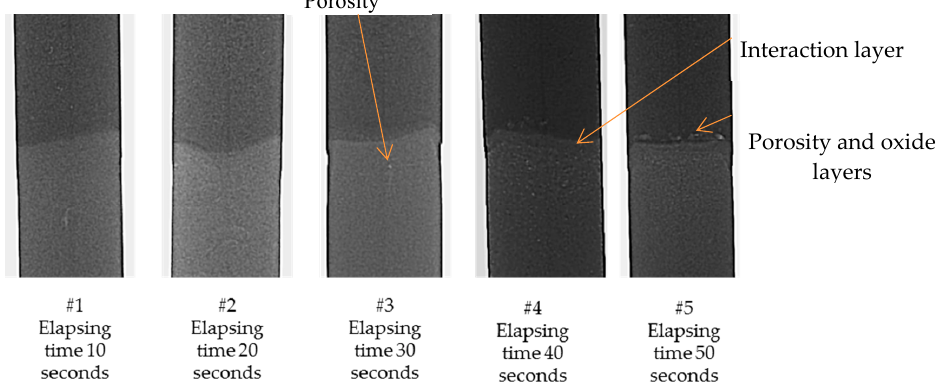
Figure 2. Sample interfaces EN AC 48000/EN AC 42100 obtained with RX analysis after sequential gravity casting at different conditions of waiting time. AlSi12CuNiMg is the dark grey part (the lower part for each image) while the other one is AlSi7Mg0.3.